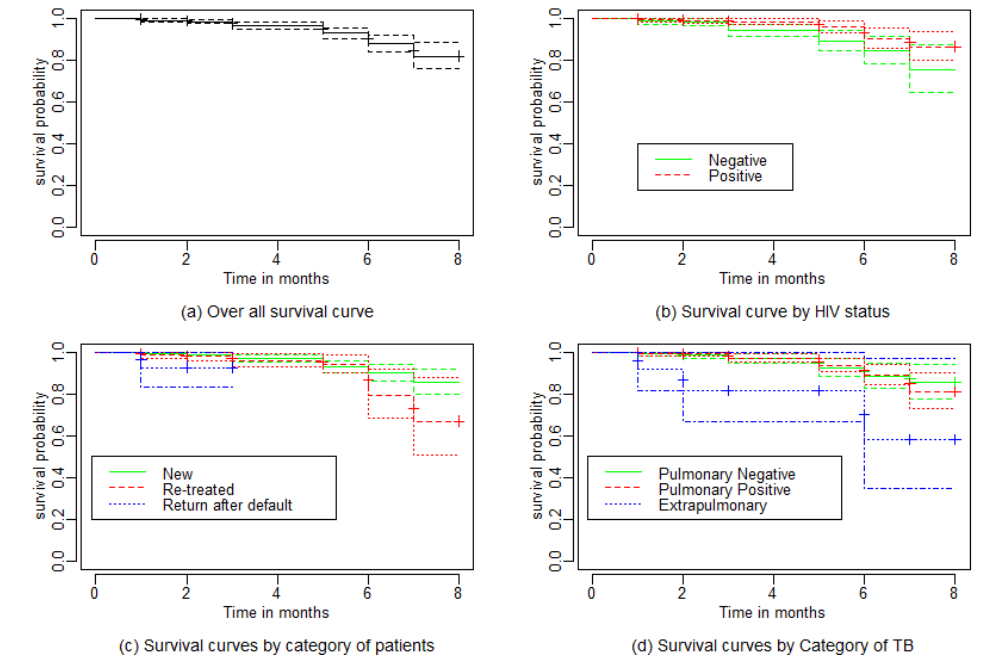
Figure 1. The Kaplan–Meier survival function plots for time to death of TB patients by ( a ) overall ( b ) HIV status ( c ) type of TB ( d ) category of